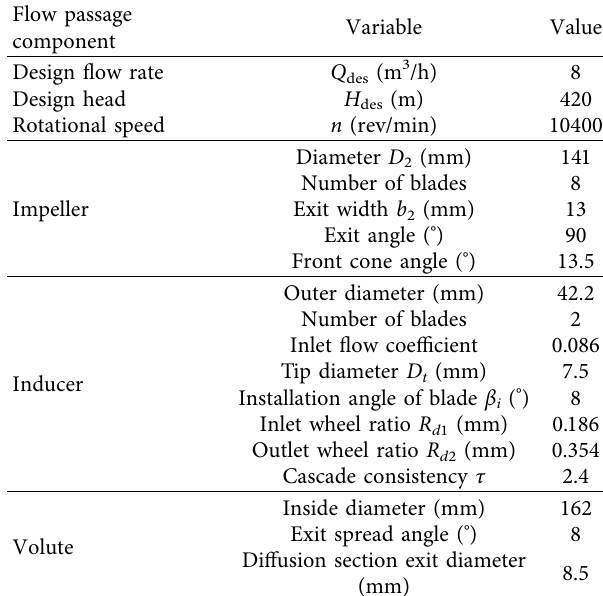
Table 1: Geometric parameters of the high-speed partial emission